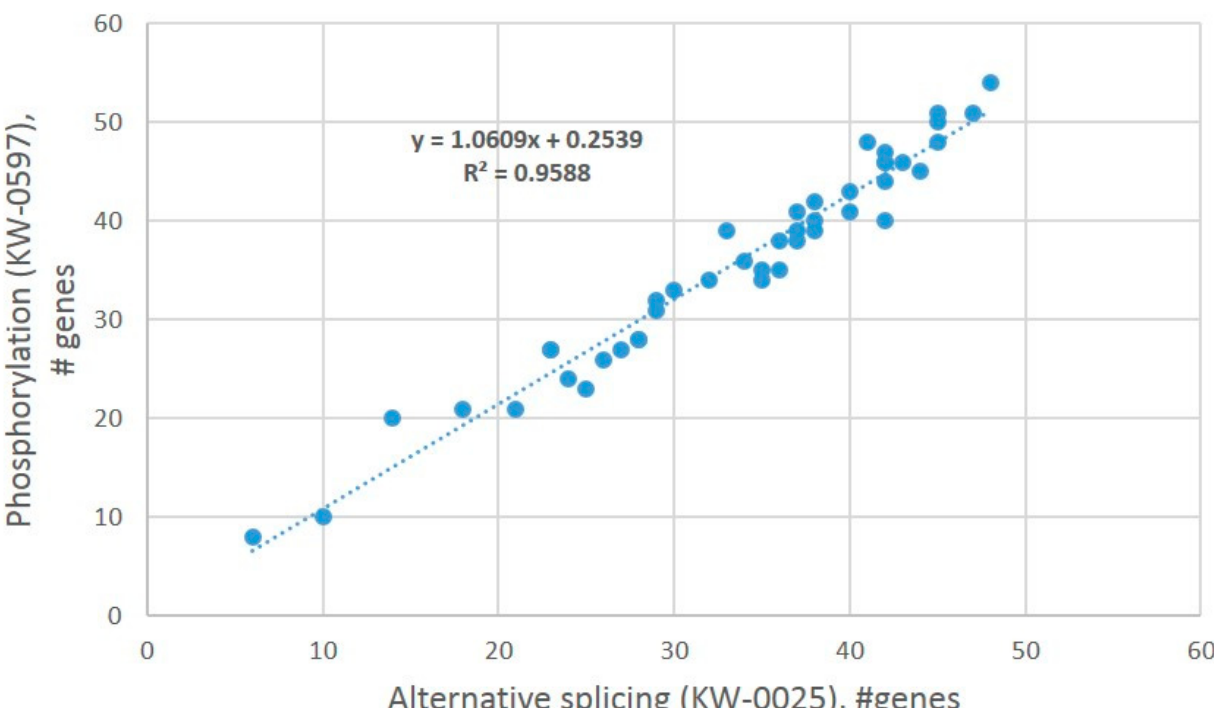
Figure 25. Significant co-occurrence ( p < 1.0 × 10 − 30 , df = 43) of AS vs. phosphoprotein GO keyword categories (UniProt) unveiled by a regression plot. GO source: string-db.org; random gene sets subsampling from merged ES abundant lists (Table S7a–c).